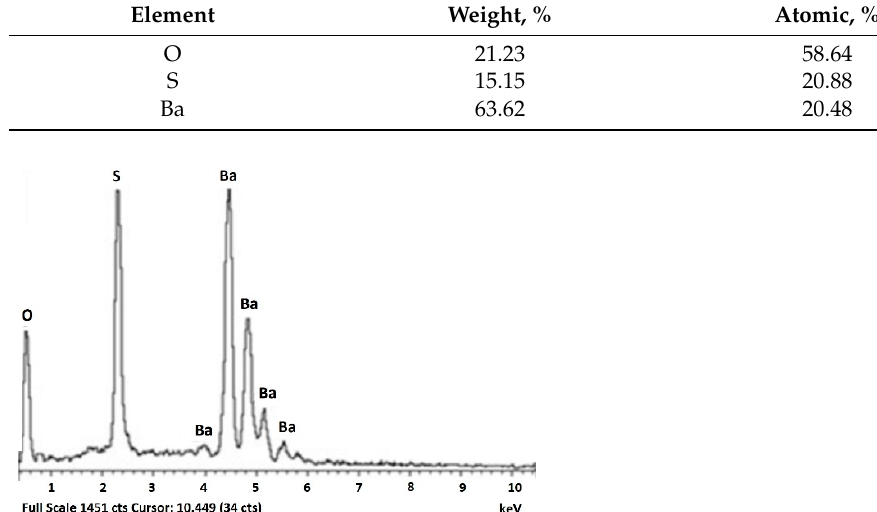
Figure 12. Spectrum of the oxidized O-Sb-Pb phase (with traces of Cu-Bi-Cl-Ag). In much of the leached slimes, there were oxidized phases that differed from each other in terms of the composition and quantity of elements present. According to the anal- ysis by the researchers of this work, decopperized anode slime has the following behavior during oxidative alkaline leaching: The decopperized slime fed into the leaching in ClO − /OH − media had a remnant AgCuSe content [8] that formed oxidized phases of the same during the leaching. The following Equations (1) and (2) can be hypothesized. AgCuSe + 4.5ClO − + OH −  AgCl + CuO + Se O (cid:2872)(cid:2870) (cid:3127) + 3.5Cl − + 0.5H 2 O